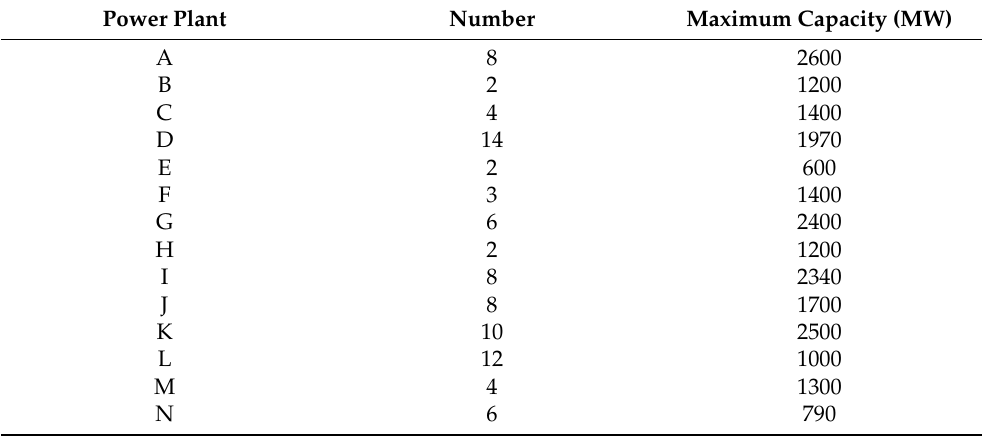
Table 1. Thermal power installed capacity of the provincial power